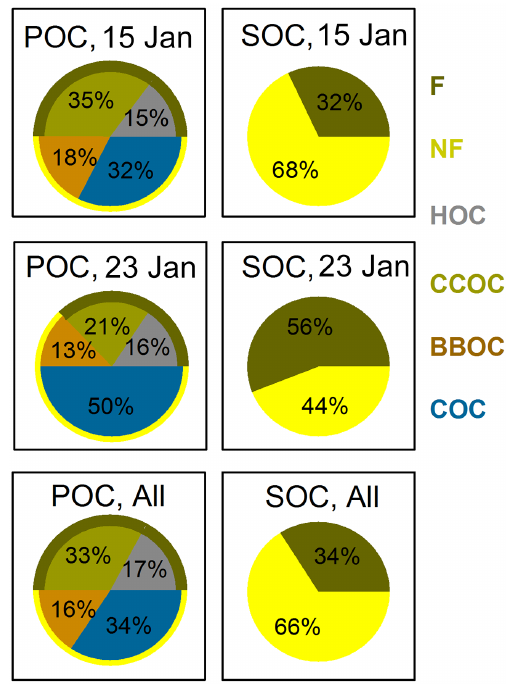
Figure 13. The NF and F carbon fraction in POC and SOC during 15 and 23 January and all data of